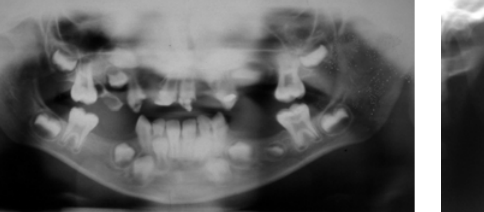
FIGURE 1- Patient at the age of 6 FIGURE 2- Patient at the age of 8 FIGURE 3- Patient at the age of 11